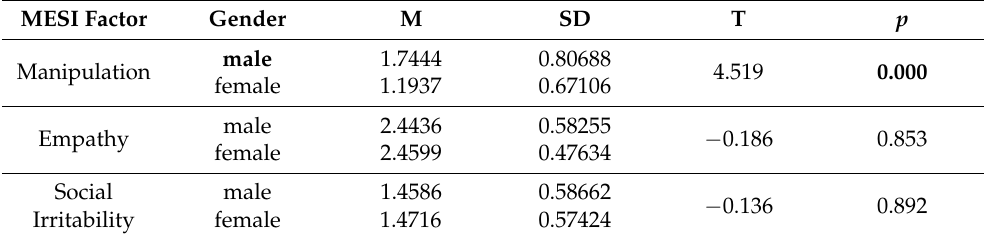
Table 2. Gender differences in the perception of social intelligence of business